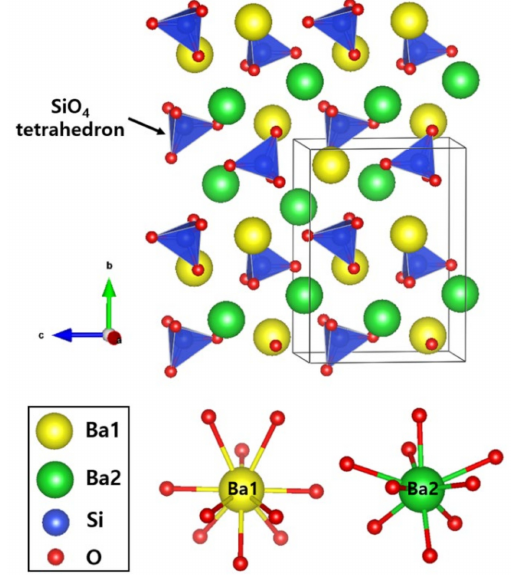
Figure 2. Unit-cell structure of Ba 2 SiO 4